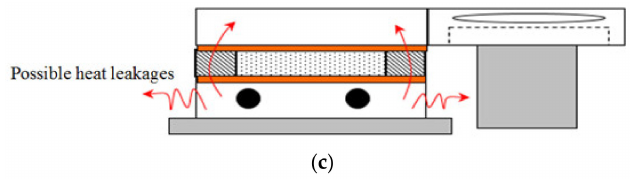
F igure 4 . Set-up of flat configuration method for thermal conductivity measurement and Figure 4. Set-up of flat configuration method for thermal conductivity measurement and possible heat